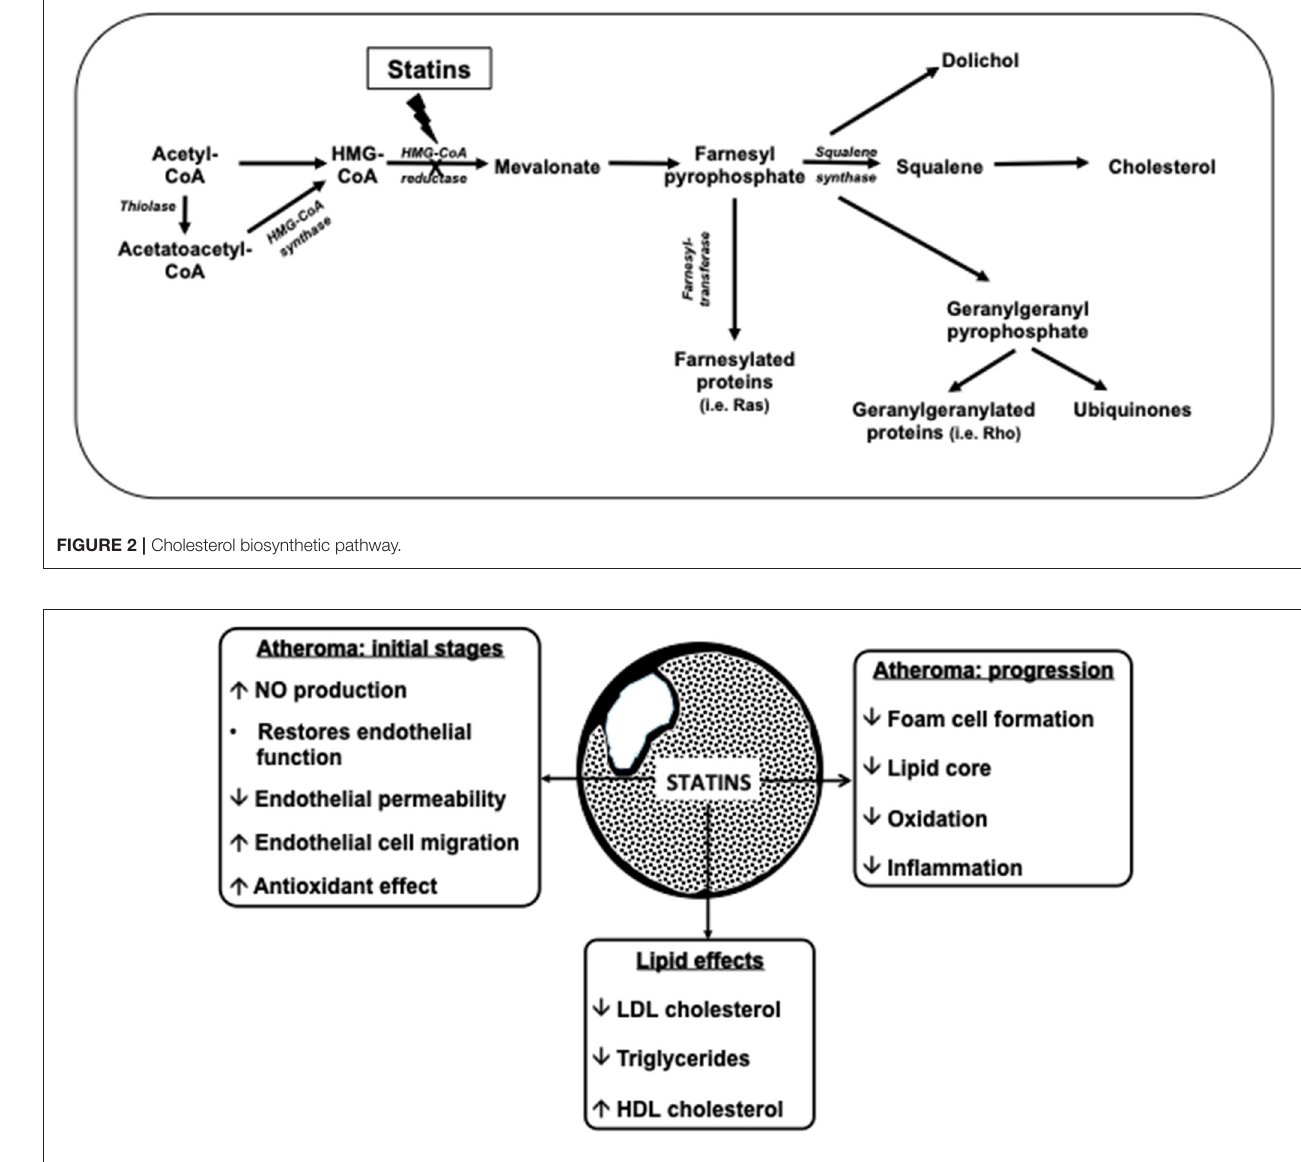
hospitalisation with statin therapy, with no effect on HF